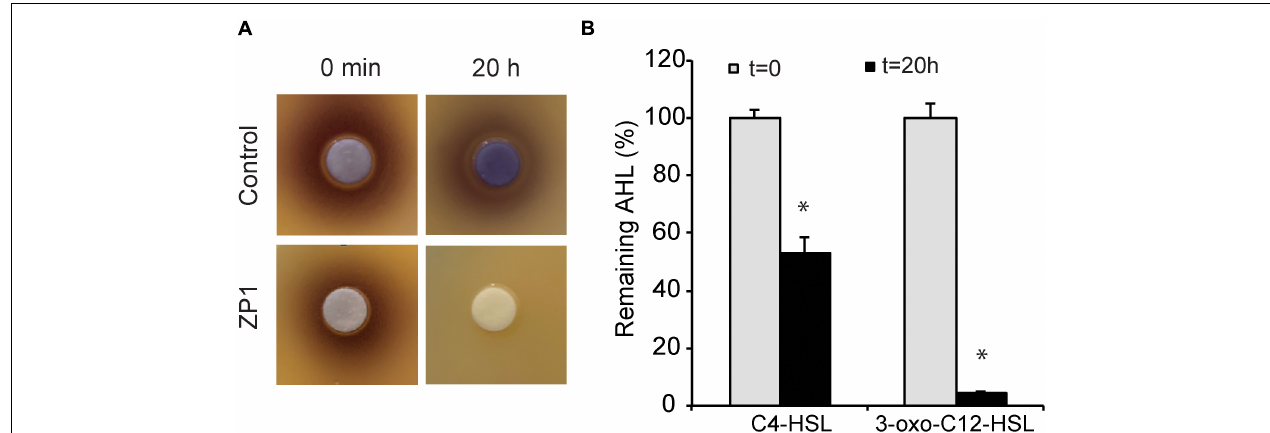
FIGURE 1 | Determination of lactonase activity. (A) Hydrolysis of C6-HSL. (B) Hydrolysis of C4-HSL and 3-oxo-C12-HSL. Values are plotted relative to buffer-treated control and are representative of two independent experiments ± SD. ∗ P < 0.05.